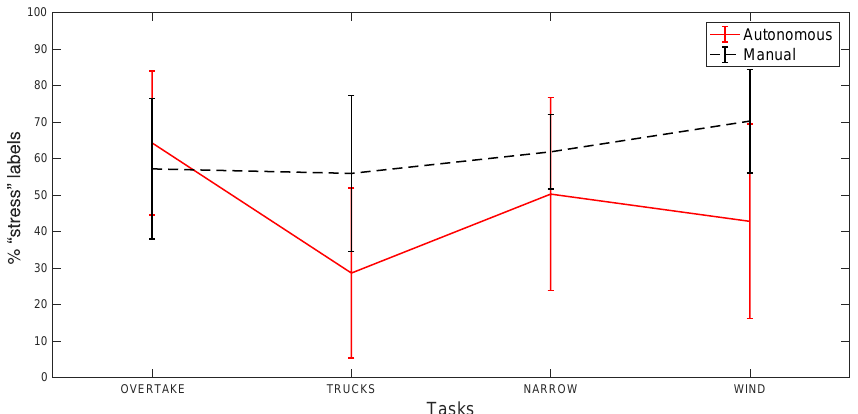
Figure 9. The number of intervals labeled as “stress” of the total of intervals during each task. This is the result of the mean computed considering all of the subjects. Error bars represent the standard deviation among the subjects.